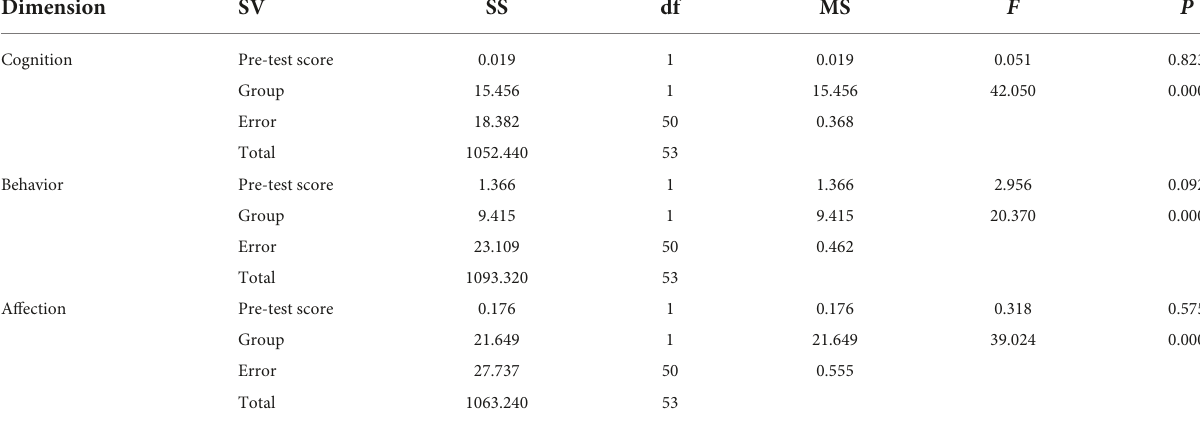
TABLE 13 The significant results of ANCOVA analysis of pre-test and post-test results of different dimensions of learning attitude. Dimension